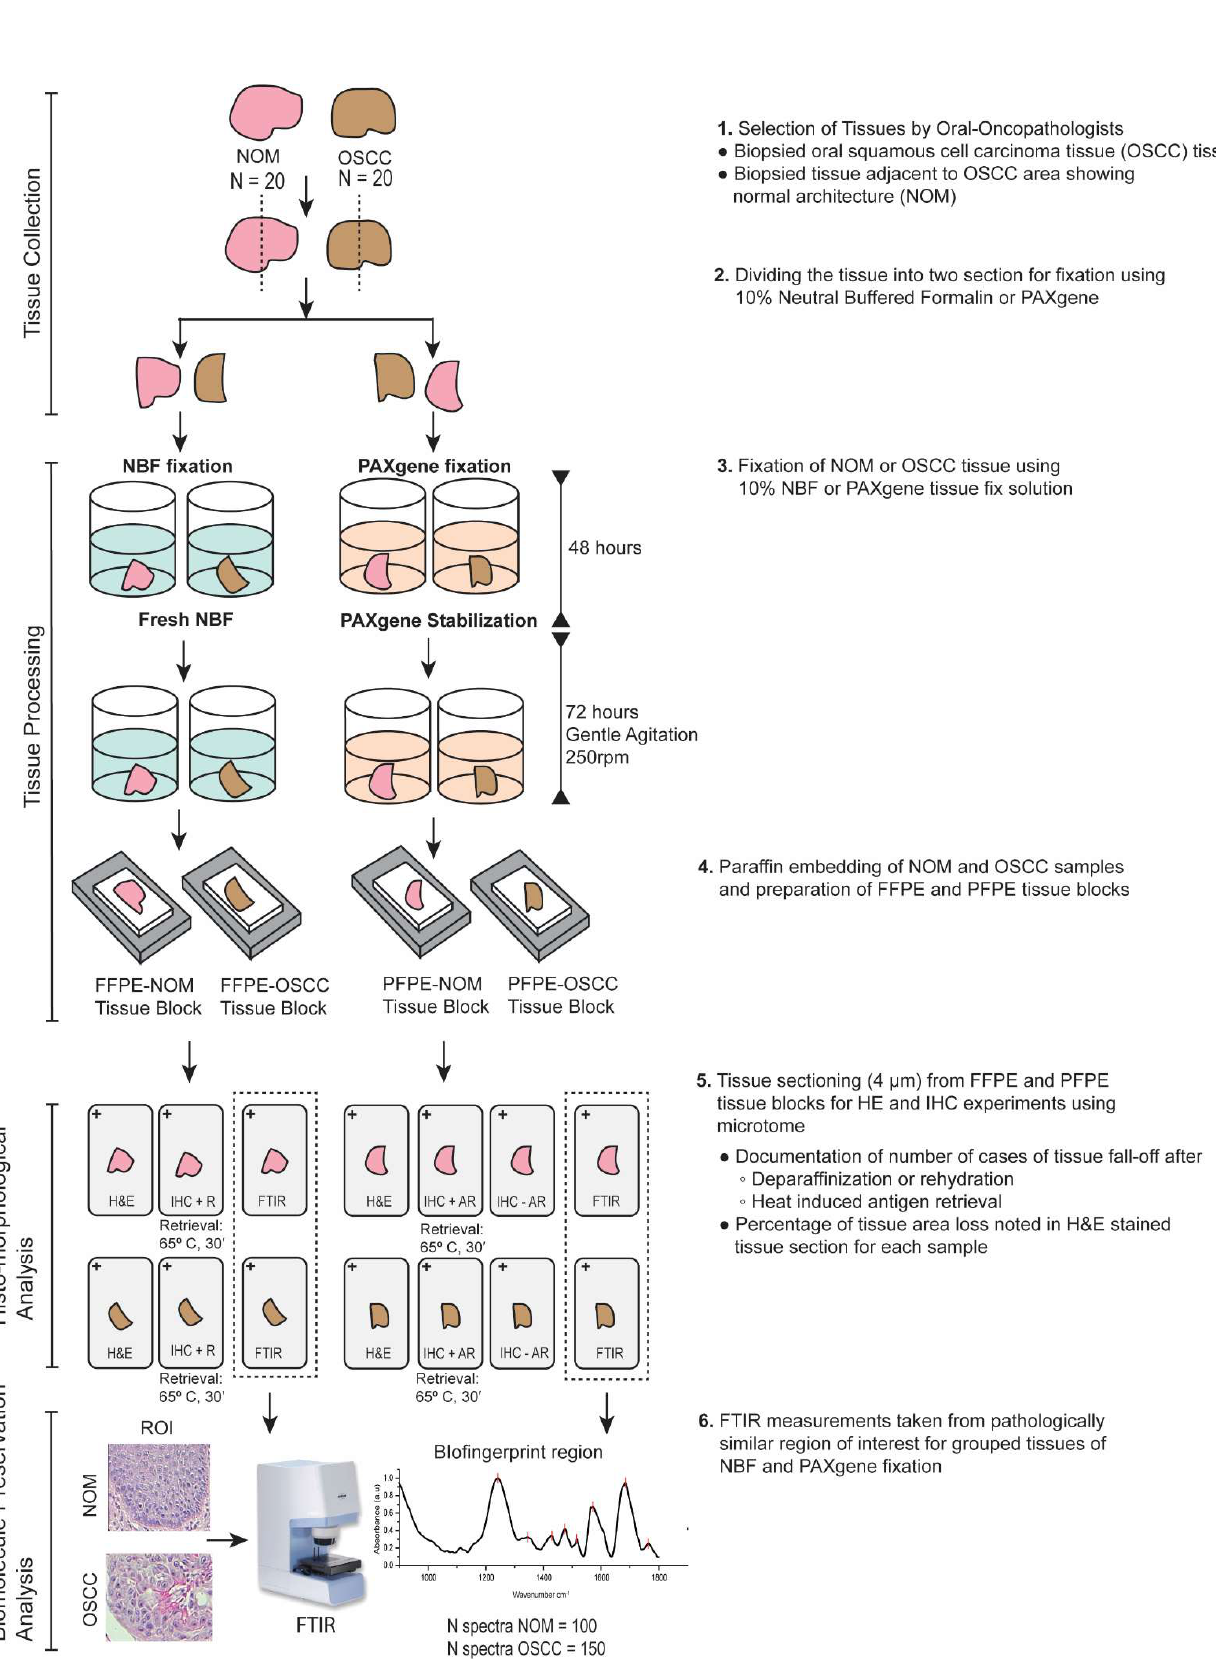
Figure 1. Sample collection and experimental setup of the study. Abbreviations: H&E, hematoxylin and eosin; IHC, immunohistochemistry; R, retrieval; FTIR, Fourier-transform infrared; AR, antigen retrieval.